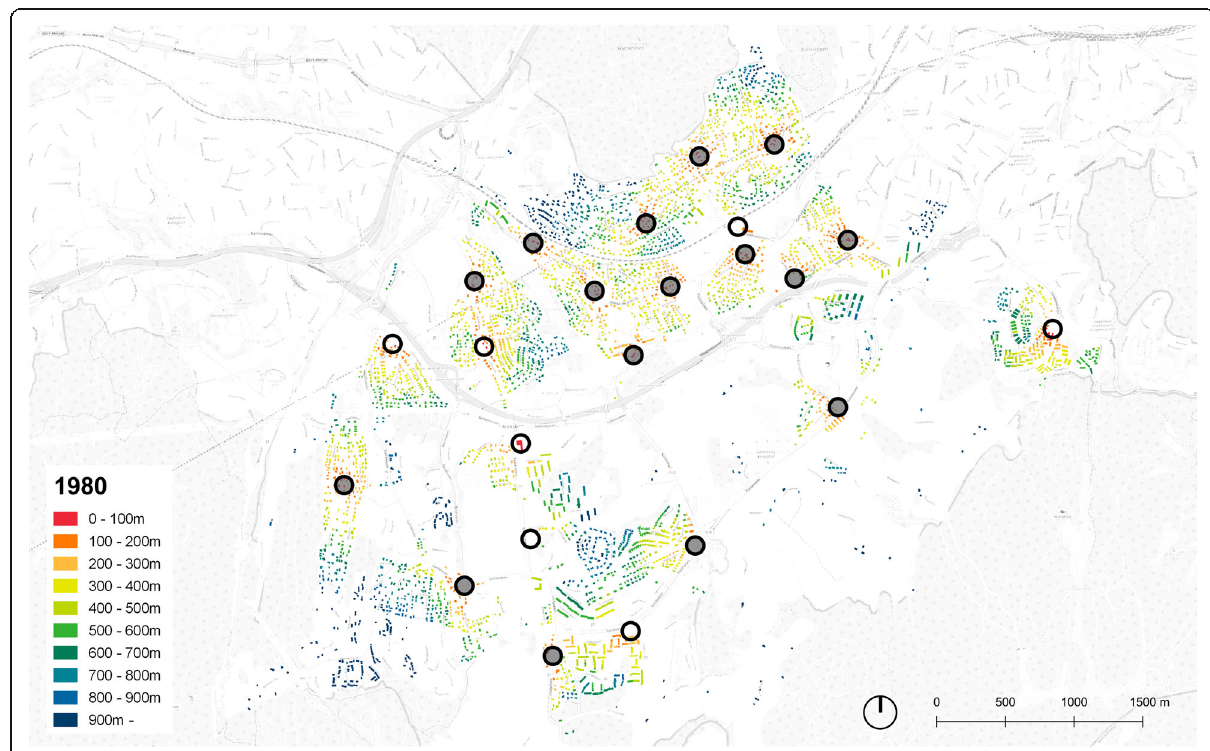
Fig. 5 Distance to grocery stores. Lørenskog, 1980. Stores marked with circles, filled circles representing stores closed down since